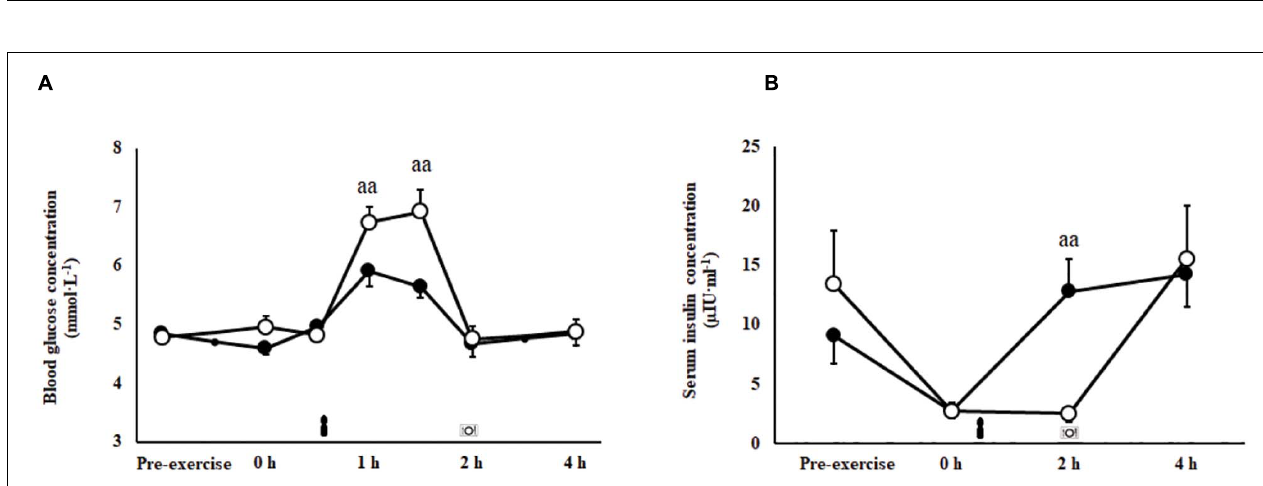
FIGURE 2 | Breath hydrogen response (A) and individual peak breath hydrogen (B) after 2 h HIIT exercise in temperate ambient conditions and consumption of a chocolate dairy milk (CM: (cid:4) ) or the carbohydrate-electrolyte (CEB: ◦ ) recovery beverage. Mean ± SEM ( n = 17): MEOTime † P < 0.05 vs. post-exercise.